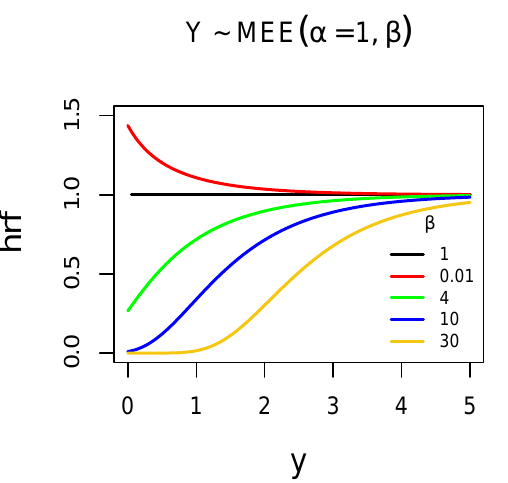
Figure 2. Plots of the hrf of MEE for different values of parameter β